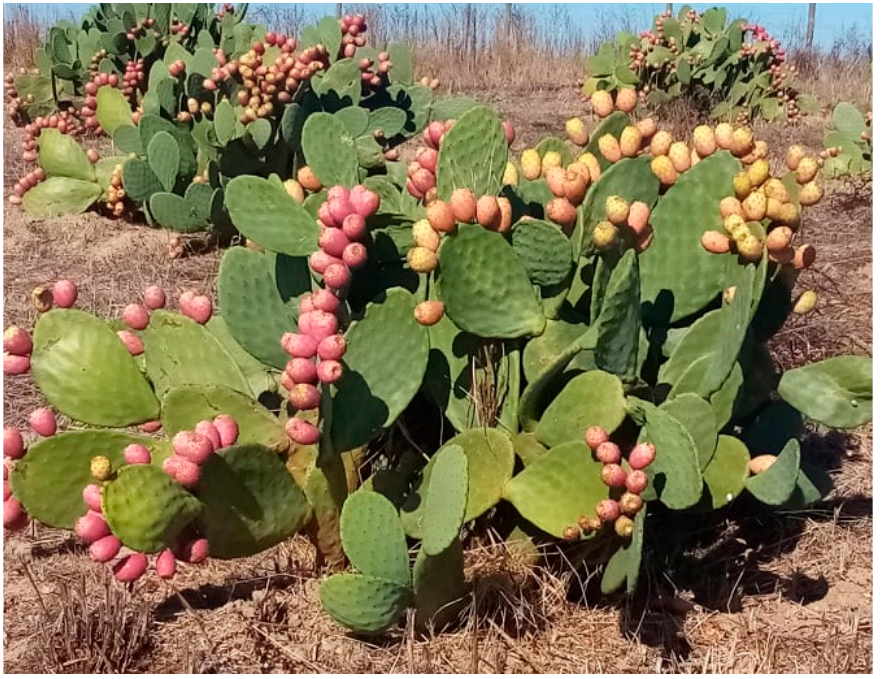
Figure 1. Opuntia fi cus-indica (L.) Mill.